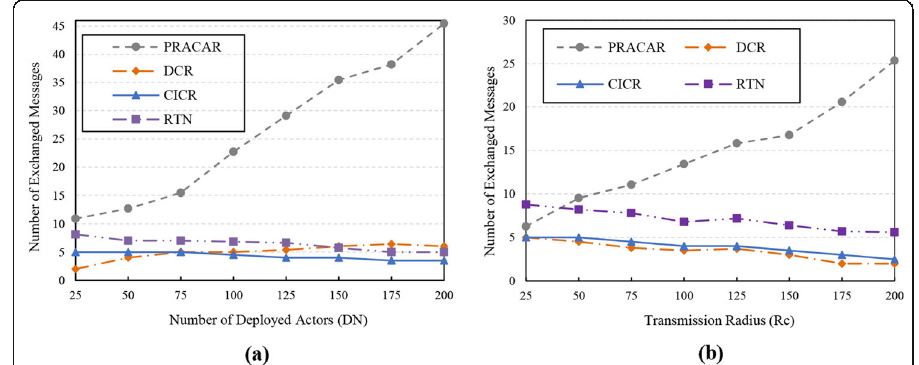
Fig. 11 The number of exchanged messages in the six partitions of network with varying ( a ) the number of actors (fixed R c = 100), ( b ) the transmission radius (fixed DN =